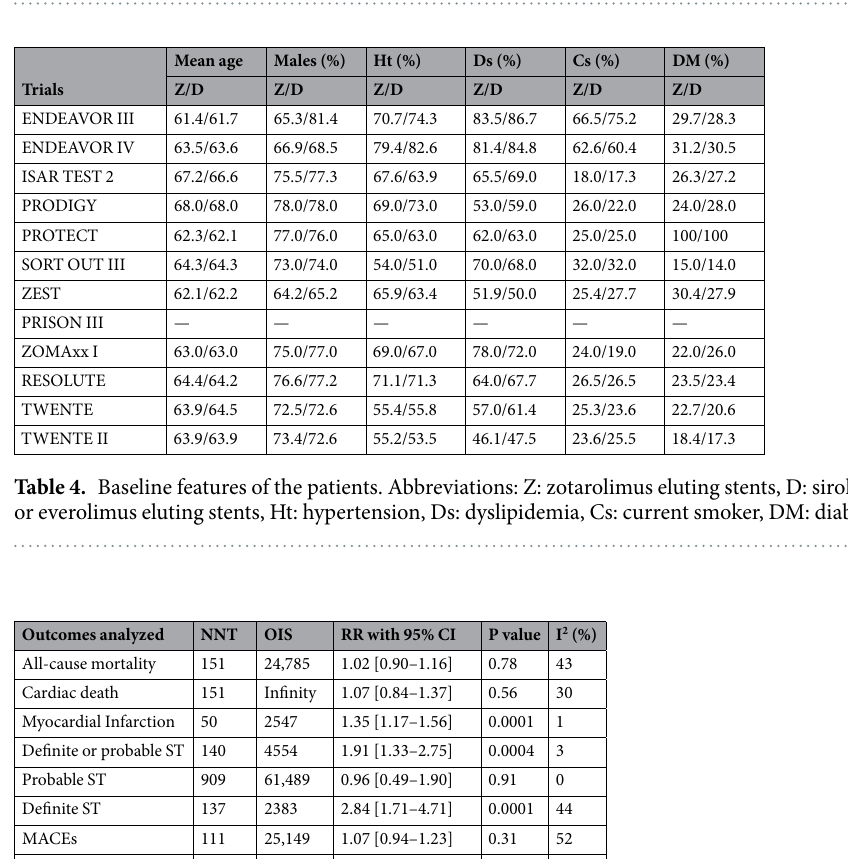
Table 3. General features of the trials which were included in this analysis. Abbreviations: DES: drug eluting stents, ZES: zotarolimus eluting stents, SES: sirolimus eluting stents, PES: paclitaxel eluting stents, EES: everolimus eluting stents.